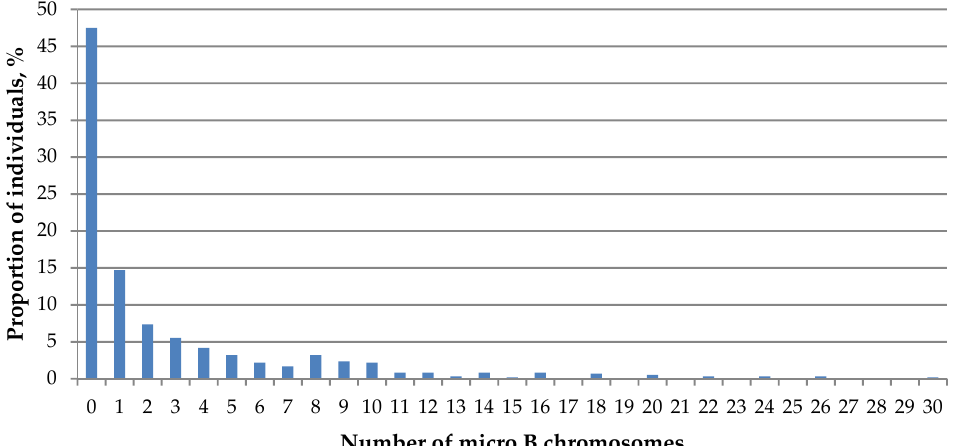
Figure 4. Ratio of A. peninsulae individuals with different numbers of B chromosomes across studied populations. LM: large metacentrics; MM: medium metacentric SM: small metacentric Ac: acrocentric.